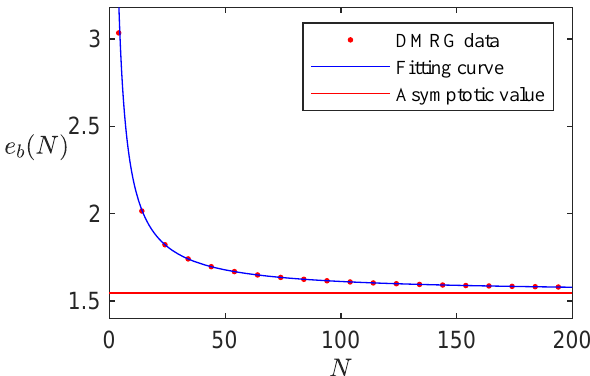
( N ) versus the system size N . The red points are the DMRG Figure 4: The values of e b ( N ) = aN β + c , where results with N = 4,14,24,...,194. The data can be fitted as e b a = 6.7308, β = − 1.0046 and c = 1.5460. Due to the fact β < 0, when the system ( N ) tend to the asymptotic value c , which gives the size N → ∞ , the values of e b boundary energy. Here the boundary parameters are chosen as p = 0.3 and q =